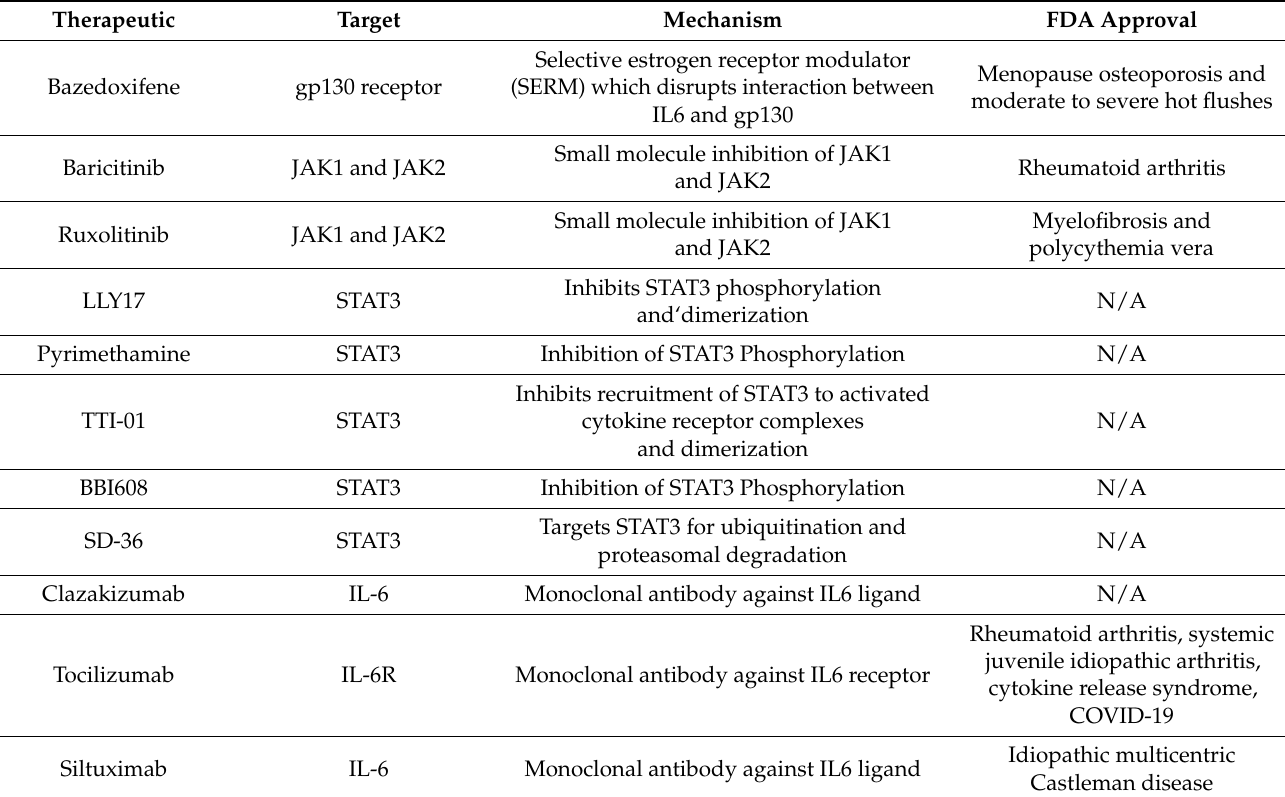
Table 1. Small molecule inhibitors and antibodies targeting IL6/STAT3